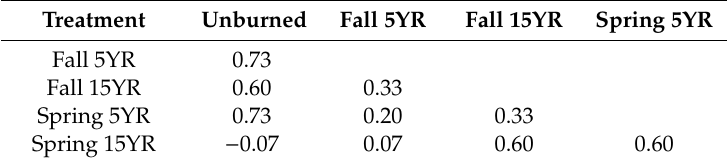
Table 4. Treatment-level trajectory convergence and divergence